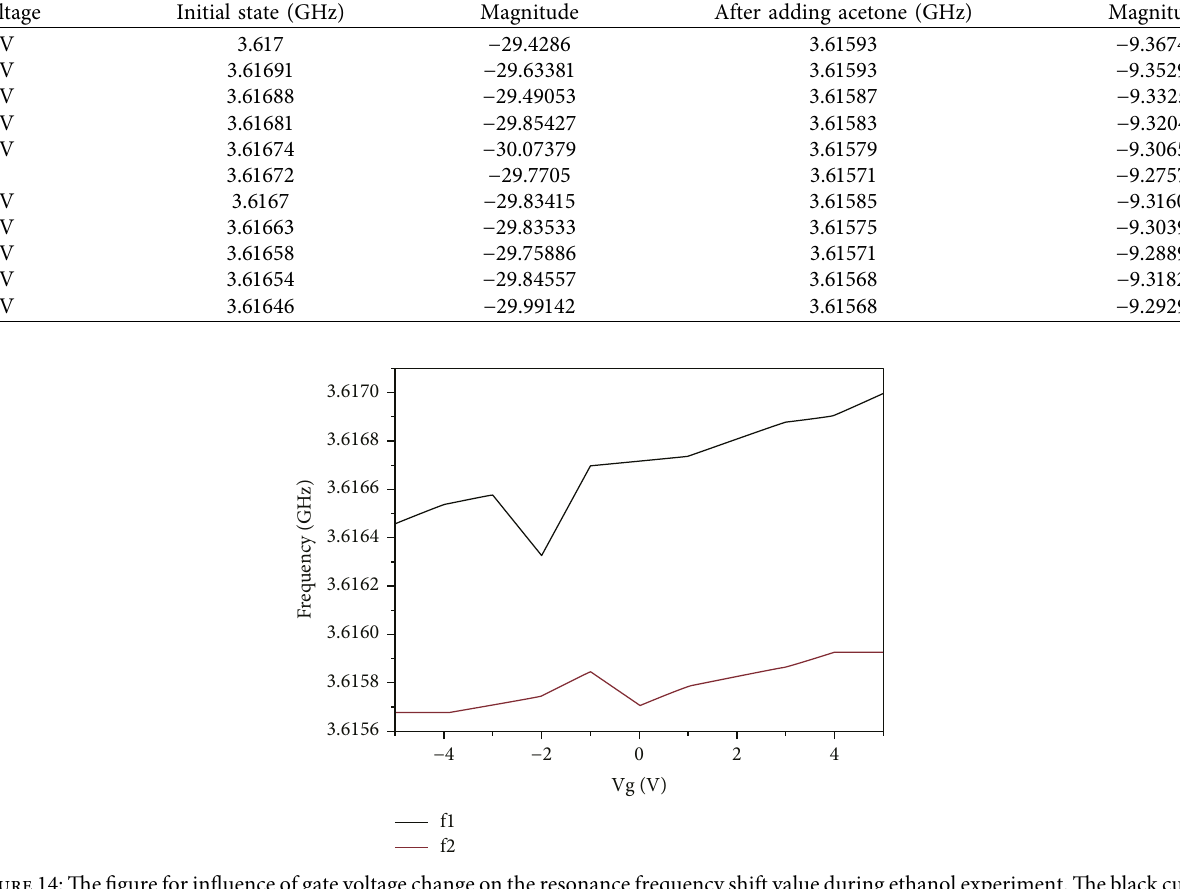
Table 5: Te resonance frequency comparison of before and after adding ethanol solutions.